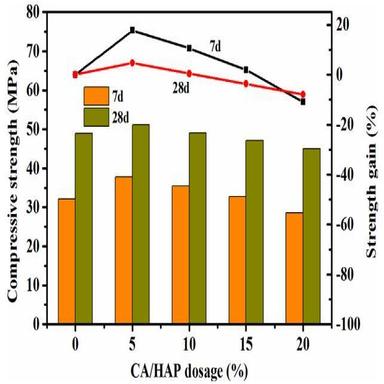
The compressive strength of cement mortars with different dosage of CA/ HAP.